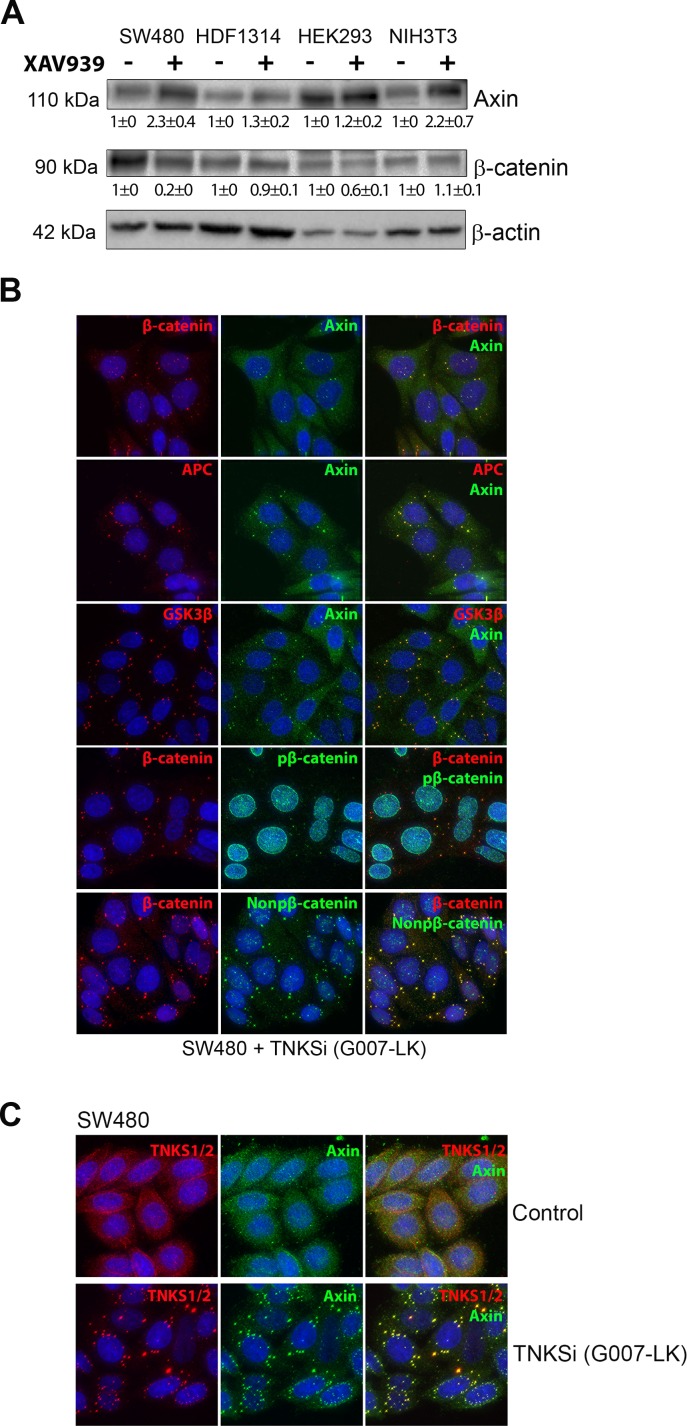
TNKSi treatment can induce axin expression and axin puncta associated with β-catenin degradation.A. Western blot analysis of different cell lines treated +/- for 24 h with 2.5 μM of the TNKSi XAV939 revealed an increase in axin expression in different cell lines, and rescue of the degradation of β-catenin in SW480 CRC cells where the wnt pathway is disrupted by APC mutation. β-actin levels are shown as loading controls. Quantification of band intensities from two separate blots was performed and normalized to actin. The values shown are mean ± SD. B. SW480 cells were treated with 5 μM of the TNKSi G007-LK for 24 h, then immunostained with specific antibodies to detect different components of the β-catenin degradation complex located at axin puncta. The following combinations of proteins were co-stained: axin and total β-catenin, APC and Axin, GSK3β and Axin and phosphorylated and non-phosphorylated β-catenin. Cells were imaged using a DeltaVision microscope system. C. SW480 control cells or cells treated with 5 μM of the TNKSi G007-LK for 24 h were stained for fluorescence. In control cells a disperse staining pattern is observed whereas in TNKSi treated cells the TNKS-1 and -2 (red) specifically colocalize at TNKSi induced axin puncta (green) as shown by immunofluorescence microscopy.